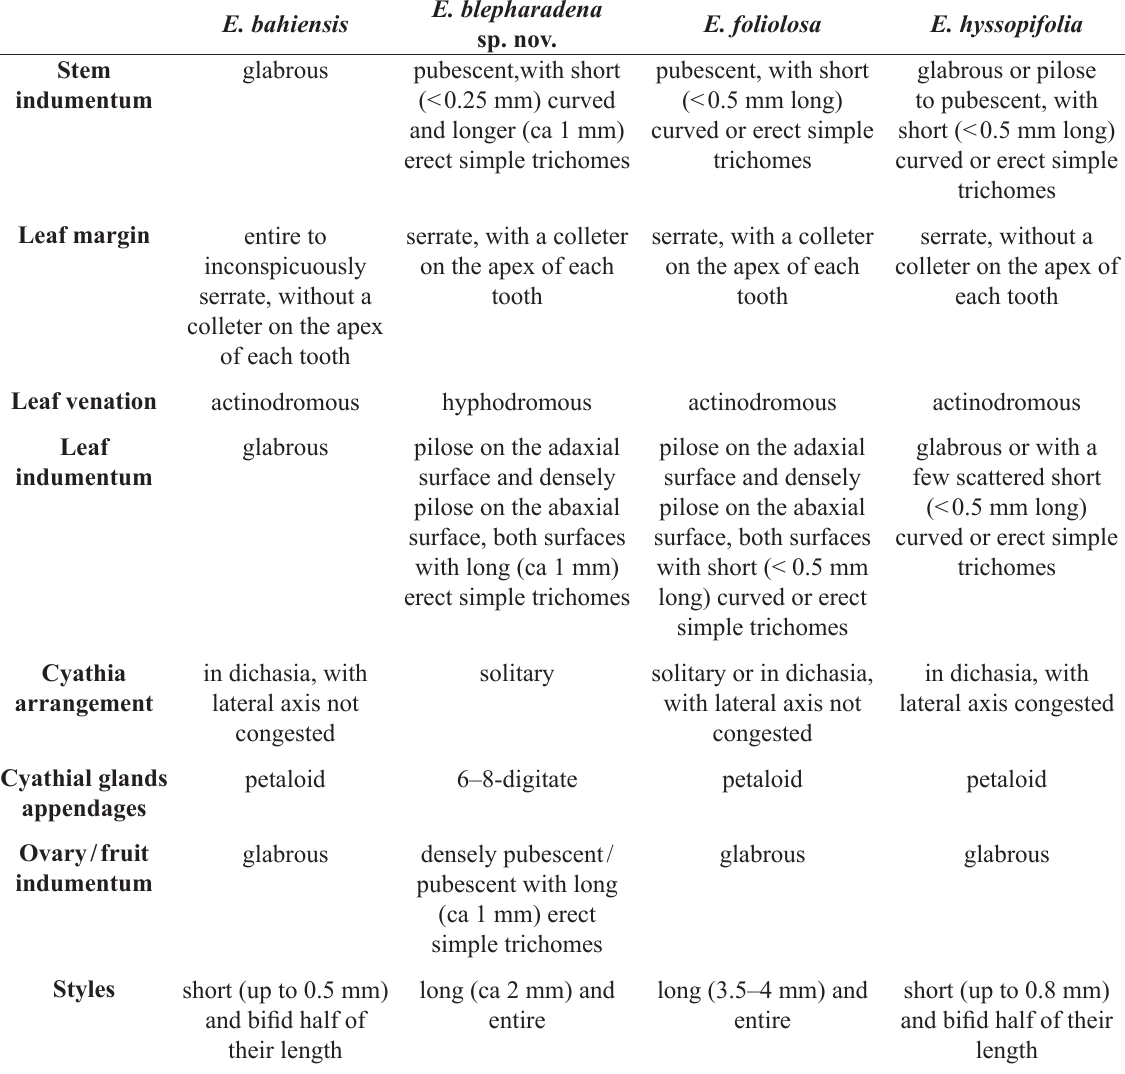
Table 1. Morphological comparison among Euphorbia bahiensis (Klotzsch & Garcke)